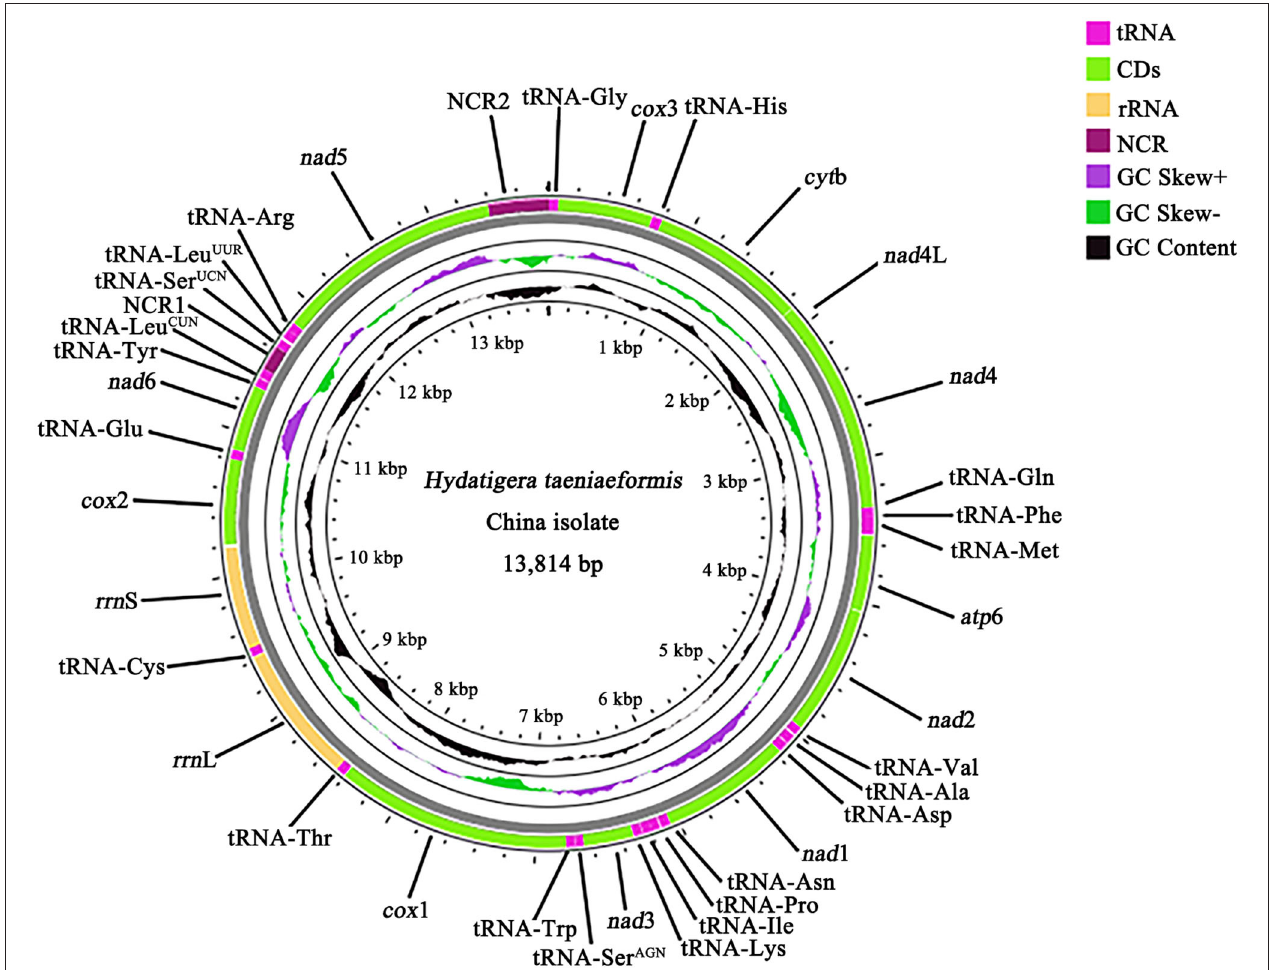
FIGURE 1 | The organization of mitochondrial genome of Hydatigera taeniaeformis China isolate. Gene scaling is only approximate. “NCR1” refers to a short non-coding region and “NCR2” refers to a long non-coding region.